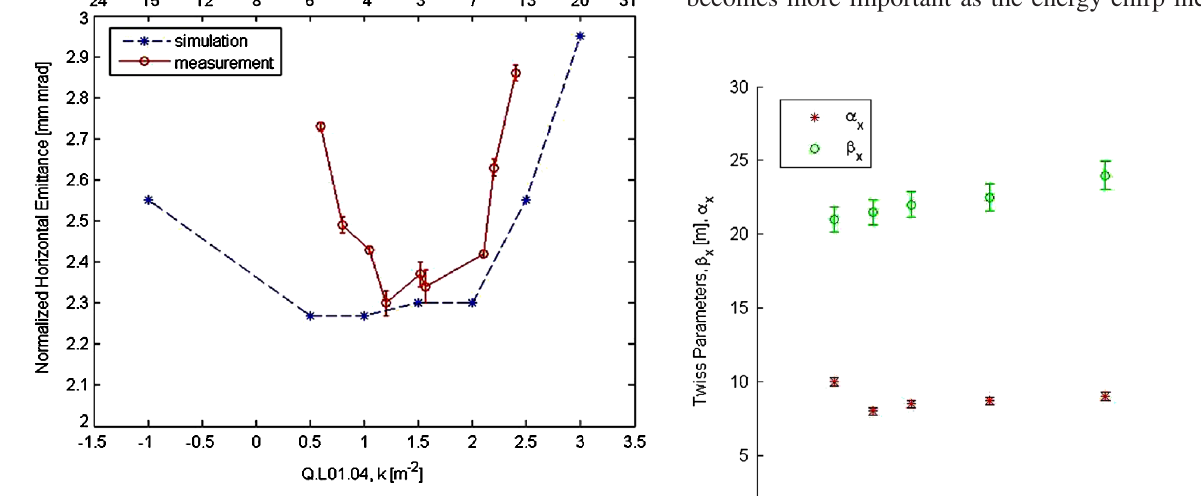
crest.FIG. 7. Comparison of measured and simulated normalized horizontal emittance as a function of the strength k of the quadrupole Q_L01.04 or, equivalently, of the expected (cid:4) the middle of the third dipole magnet of BC1. The design optics foresees k ¼ 1 : 625 m (cid:1) 2 . Other relevant parameters include C ¼ 6 : 5 with BC1 at 85 mrad bending angle and L1 rf phase at 25 (cid:3) far from crest. The ELEGANT simulation includes both CSR and LSC